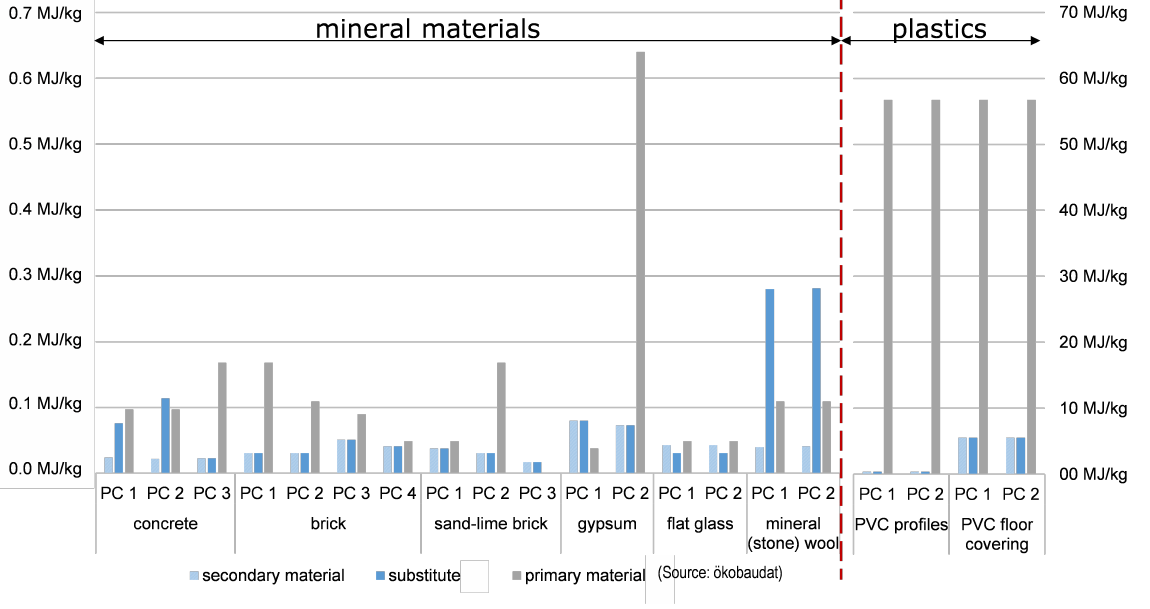
Figure 2. Energy expenditures of the selected construction products - a